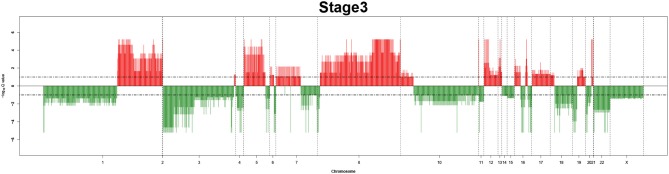
Recurrent genome-wide SCNAs in stage 3. Genome-wide amplifications (red blocks) and deletions (green blocks) in stage 3.